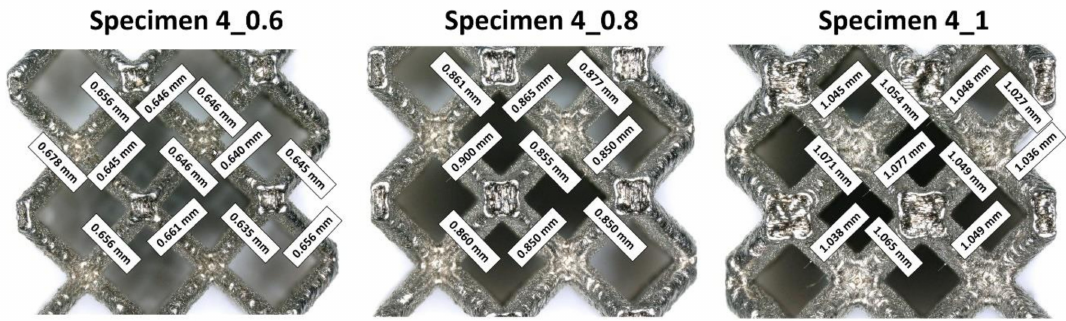
Figure 6. The dimensional deflections of the lattice structure struts relative to the assumed strut diameter and unit cell size.